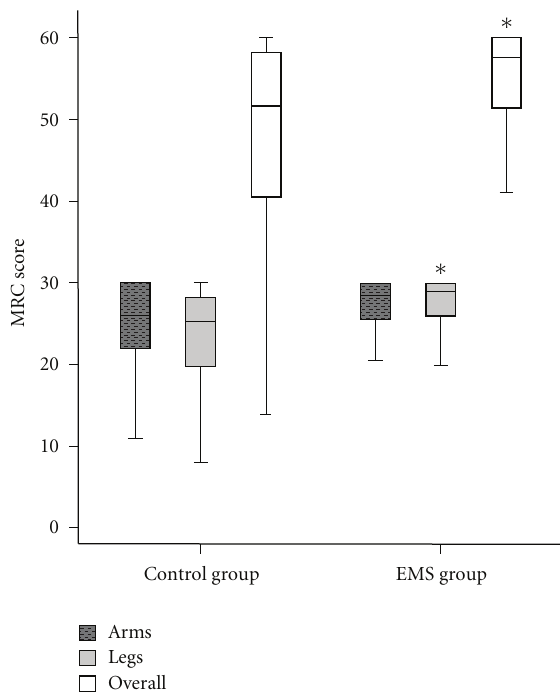
Figure 2: Arms, legs, and overall MRC scores (median, interquartile range) for EMS and control groups. ∗ Significant between-group di ff e- rence ( P < 0 . 05).